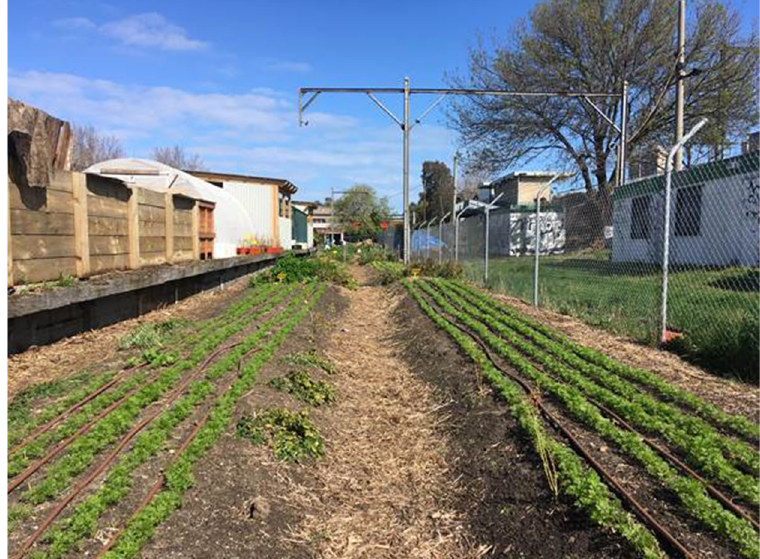
Figure 1. FareShare Garden, Abbotsford, Victoria.